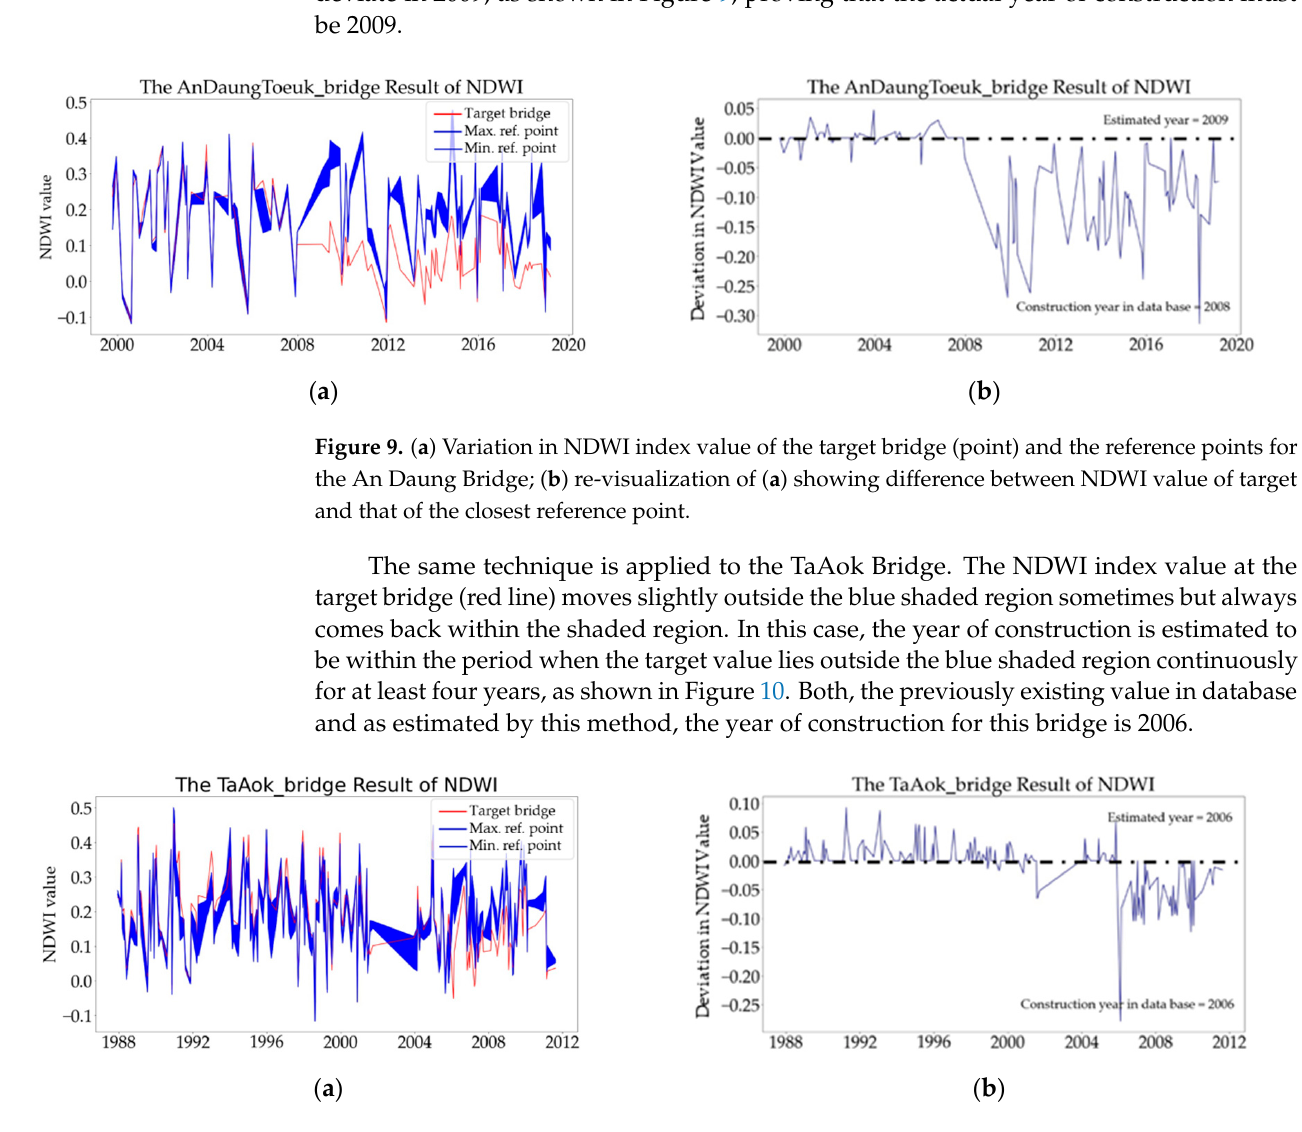
Figure 8. ( a ) Variation in NDWI index value at the target bridge (point) and reference points over time for the Sre Ambel Bridge; ( b ) re-visualization of ( a ) showing difference between NDWI of tar- get and that of the closest reference point.